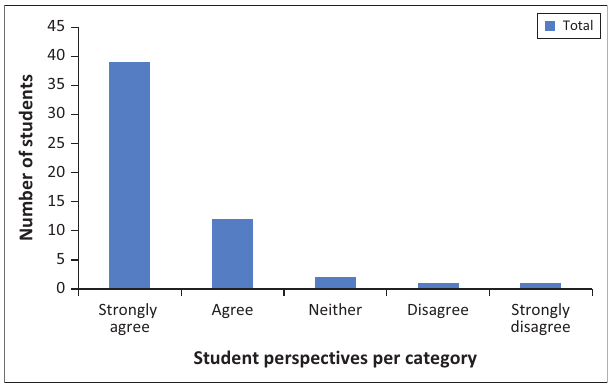
FIGURE 7: Necessity of workshops to assist students’ approach to